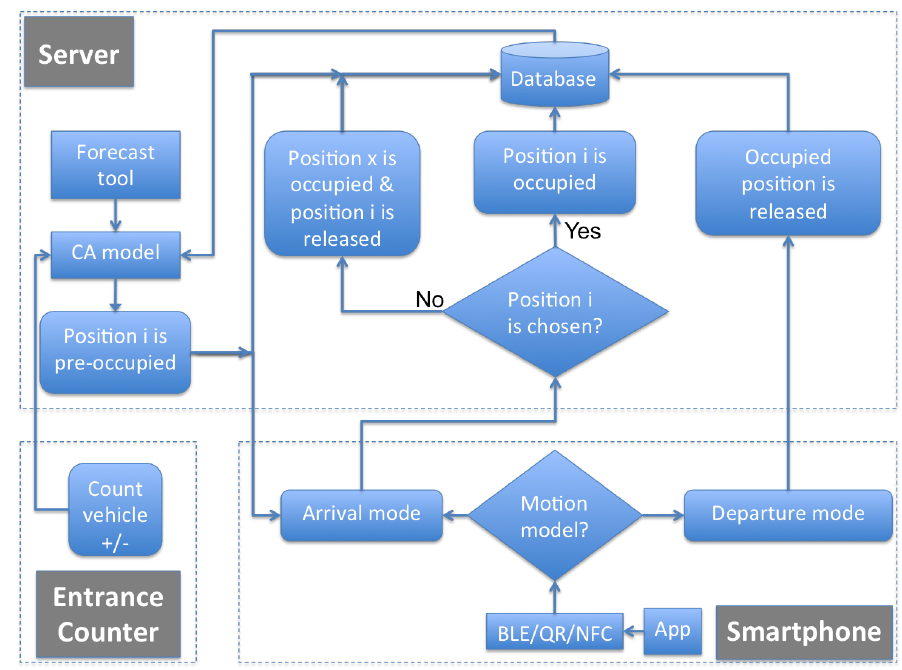
Figure 4. High-level architecture of the indoor parking